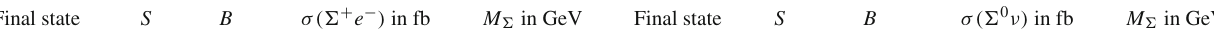
sections σ((cid:2) ± e ∓ ) , σ((cid:2) 0 ν) and the number of signal ( S ) and back- ground ( B ) events after employing the selection criteria are also